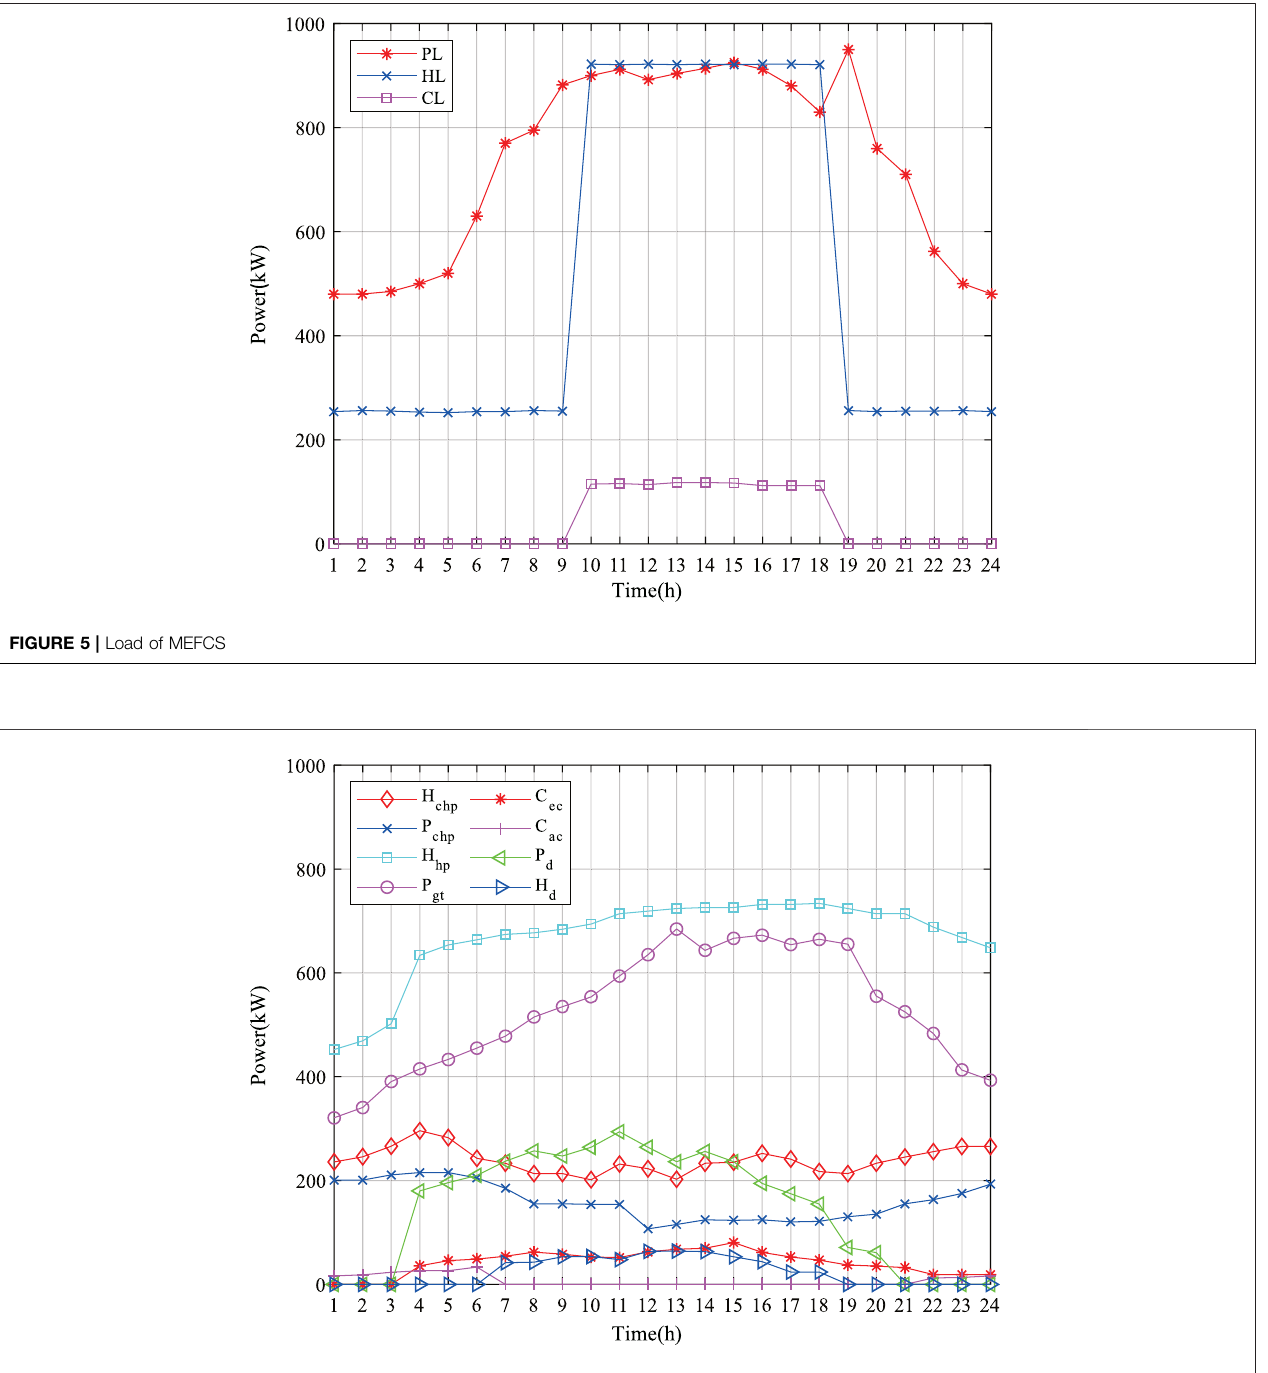
FIGURE 6 | Output of each equipment of MEFCS.